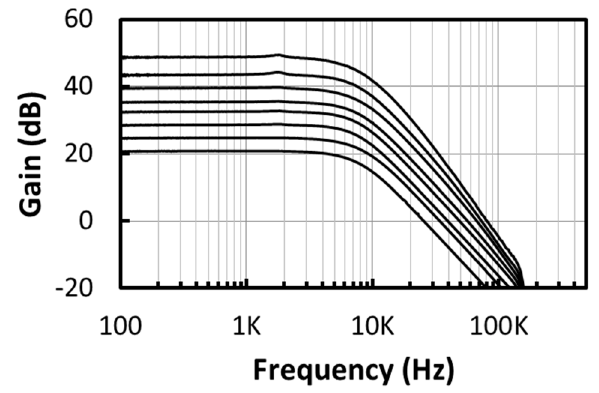
Figure 13. The measured frequency responses of the variable-gain chopper IA.